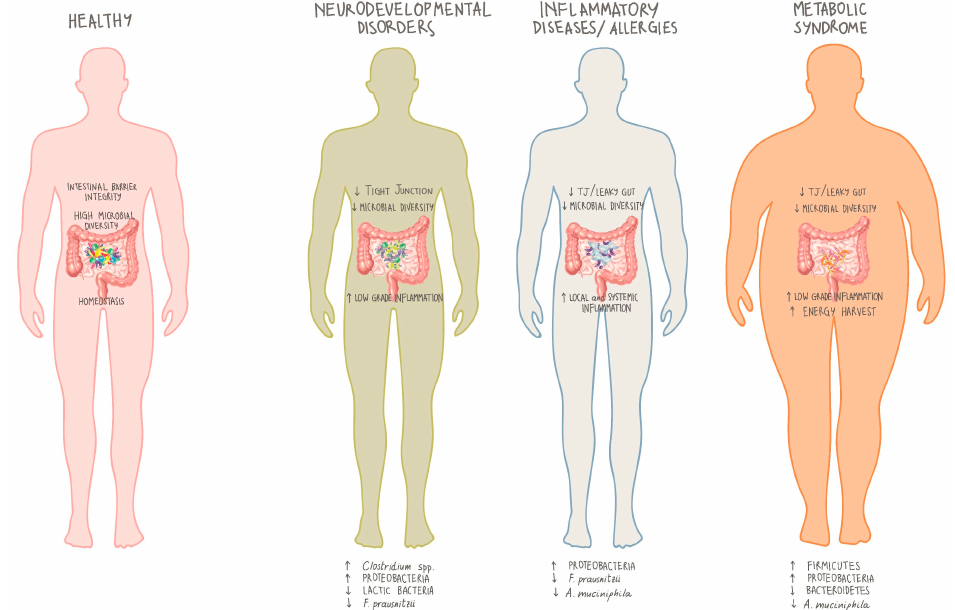
Figure 2. Microbial signature in health and disease and its impact on gastrointestinal homeostasis. Up and down arrows indicate increase and decrease, respectively. TJ = tight